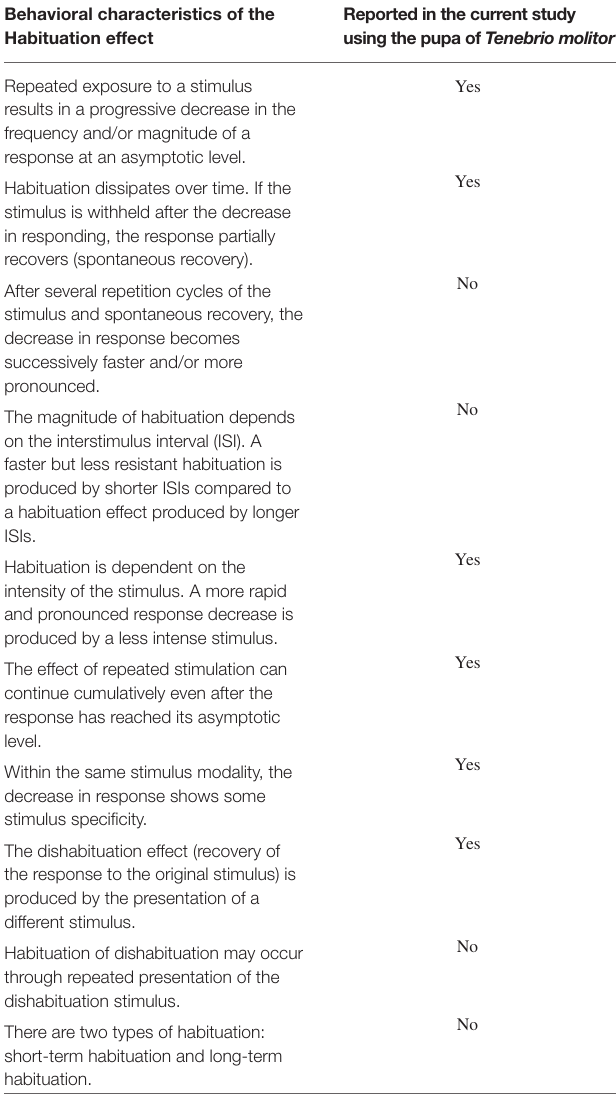
Reported in the current study using the pupa of Tenebrio molitor